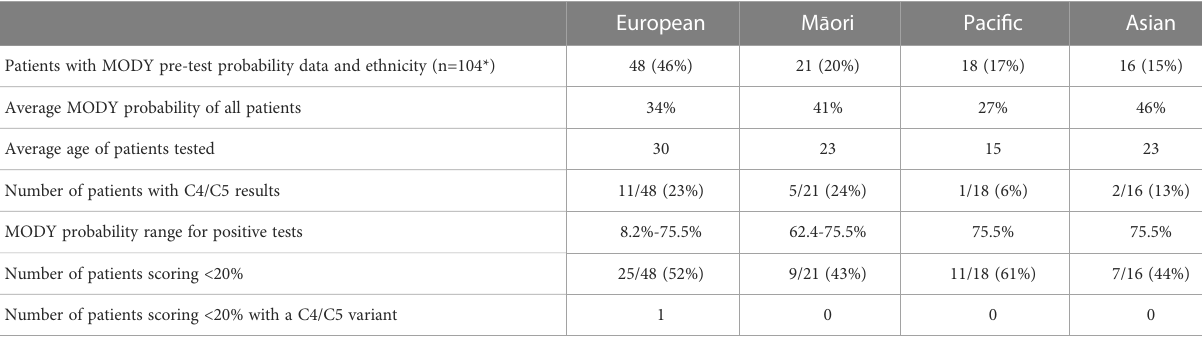
TABLE 1 MODY pre-test probability by